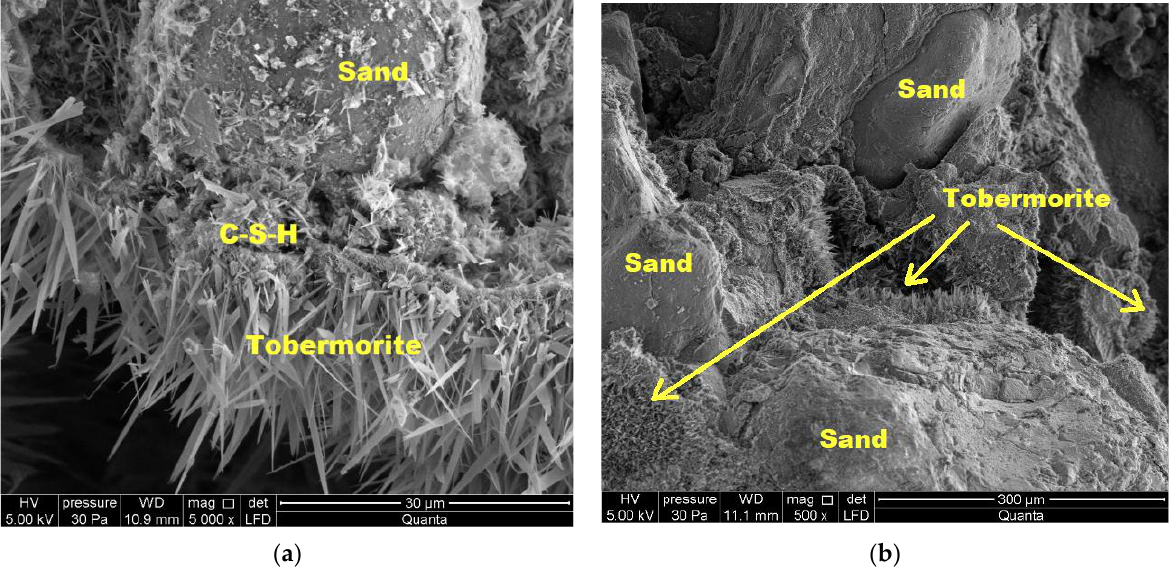
Figure 13. Microstructure of traditional sand-lime bricks; ( a ) industrial production; ( b ) laboratory production.